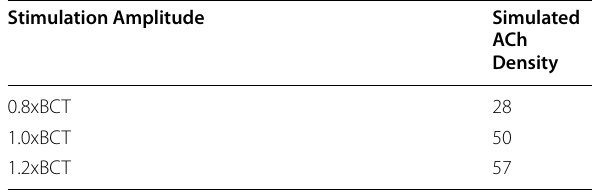
Table 1 Number of the 100 sinoatrial node cells that received VNS-evoked ACh release (i.e., ACh density) across stimulation amplitudes (0.8-, 1.0-, and 1.2-times bradycardia threshold (BCT)) in a computational model of parasympathetic innervation of the sinoatrial